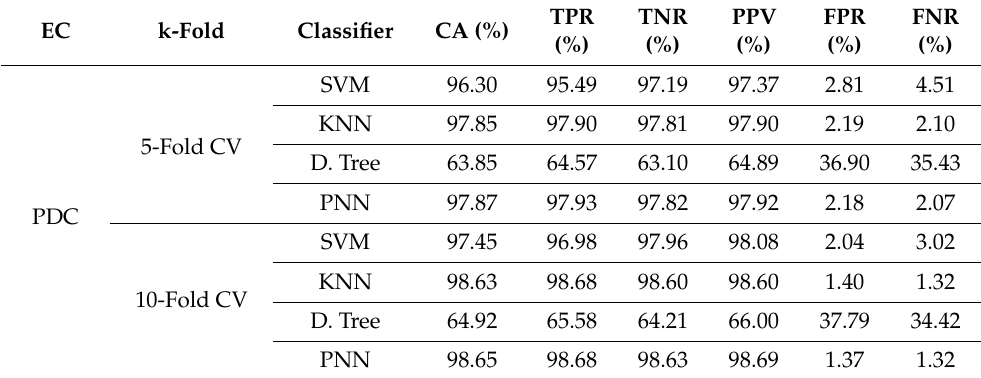
Table 2. Performance in left/right MI EEG classification when using the PDC. EC